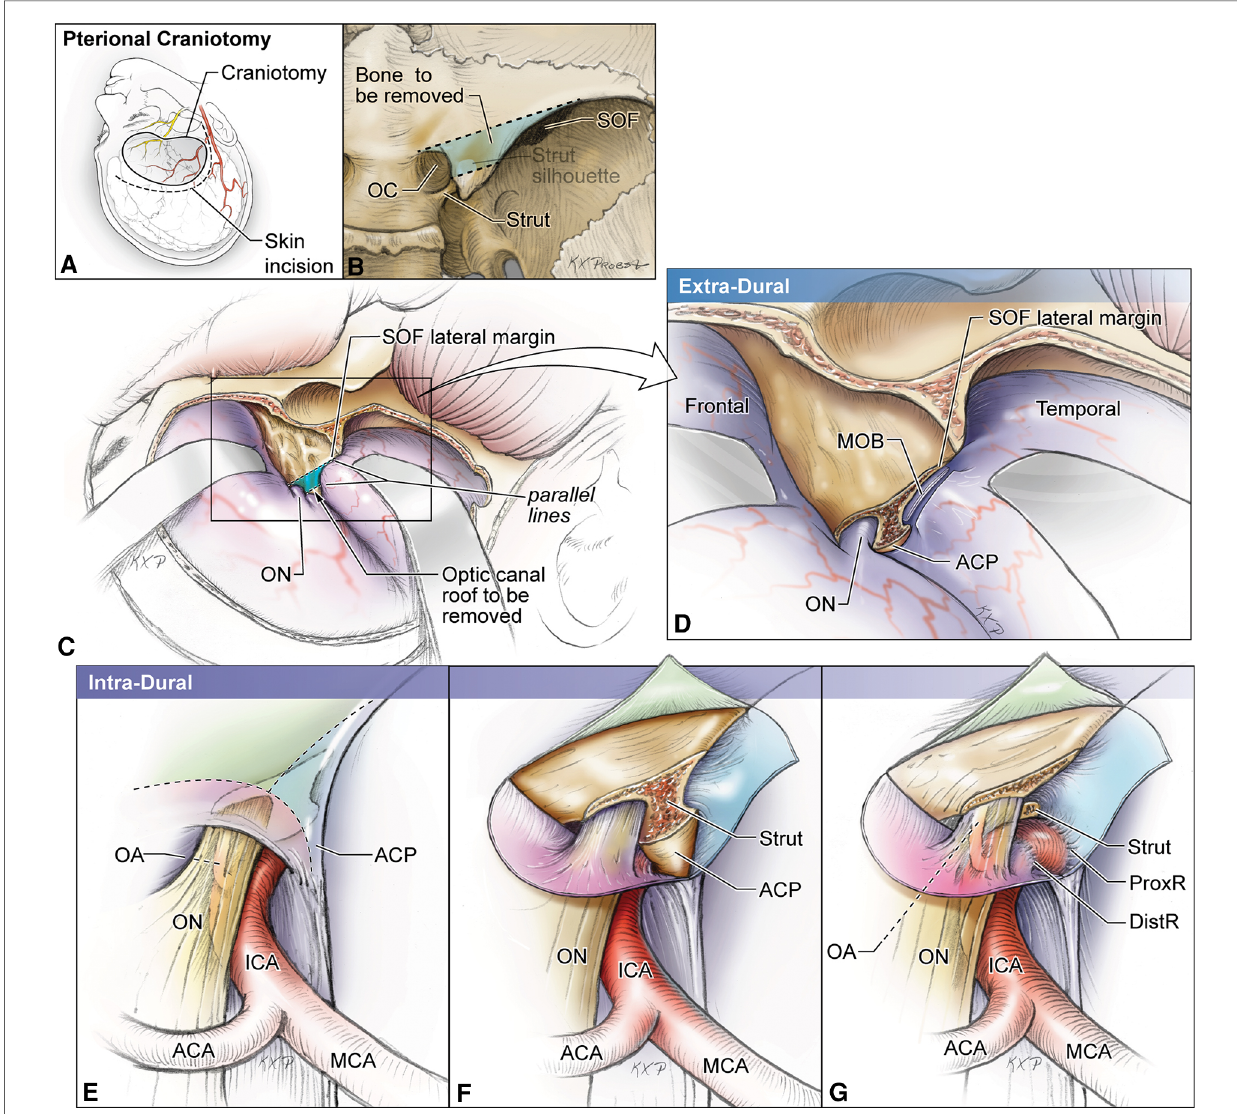
FIGURE 3 Artist ’ s illustration of the two-step hybrid anterior clinoidectomy using skull base landmarks to identify the location of the optic strut. ( A,B ) Craniotomy and skin incision. Once the optic canal is identi fi ed extradurally, a line is drawn from its medial aspect to the lateral end of the superior orbital fi ssure. Next, a parallel line is drawn from the lateral aspect of the optic canal and the bony area between these lines delineates the anterior root of the anterior clinoid. ( C,D ) Extradural stage. The meningo-orbital band is cut, and the trapezoid area of bone between the two lines is drilled out and the strut is exposed. This stage unroofs the OC. ( E – G ) Intradural stage. Cuts are placed over the ACP dura to expose the tip of the clinoid process and the optic strut, which will be removed during this stage. ACA, anterior cerebral artery; DistR, distal dural ring; MCA, middle cerebral artery; MOB, meningo-orbital band; OA, ophthalmic artery; OC, optic canal; ON, optic nerve; ProxR, proximal dural ring; SOF, superior orbital fi ssure. (Copyright Michael T. Lawton. Used with